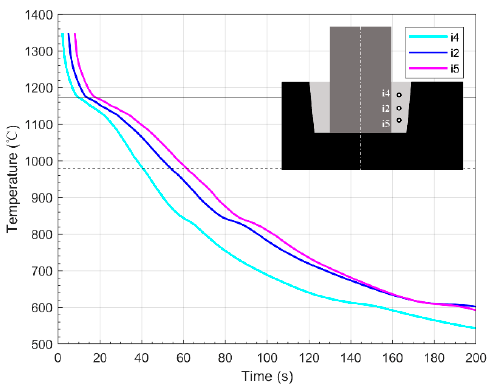
Figure 18. The cooling cures of i4, i2, and i5 in cast iron.